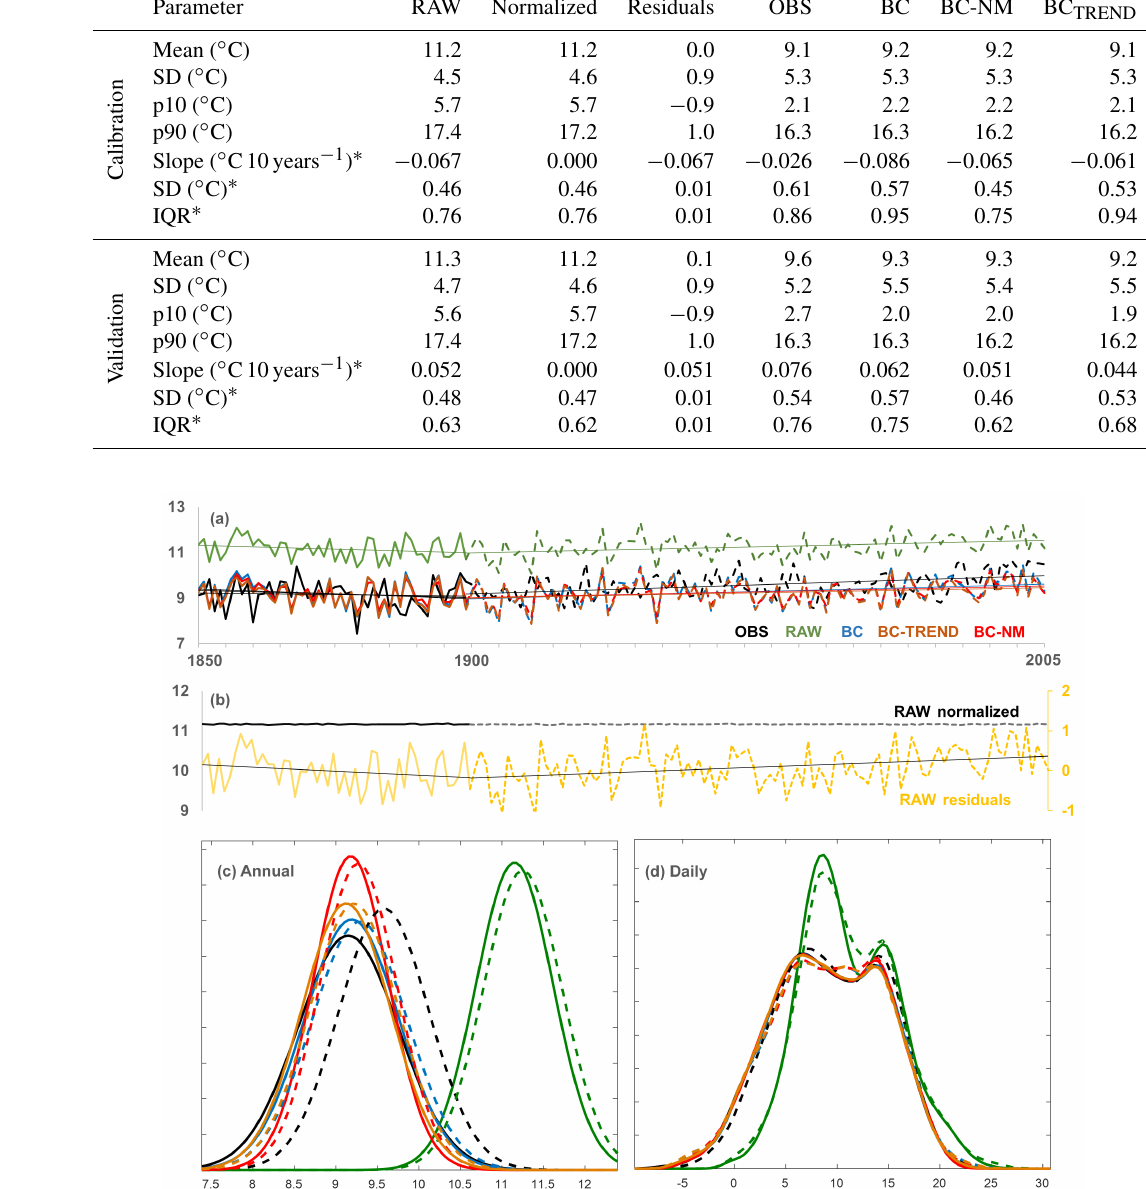
Figure 5. (a) Annual average temperature of raw model, observations and the bias-corrected with and without the NM data and following the BC-TREND approach, for the calibration period 1850–1899 (solid lines) and the validation period 1900–2005 (dashed lines). (b) Annual averages of the normalized and the residuals of the raw temperature. Probability densities of annual (c) and of daily means (d)